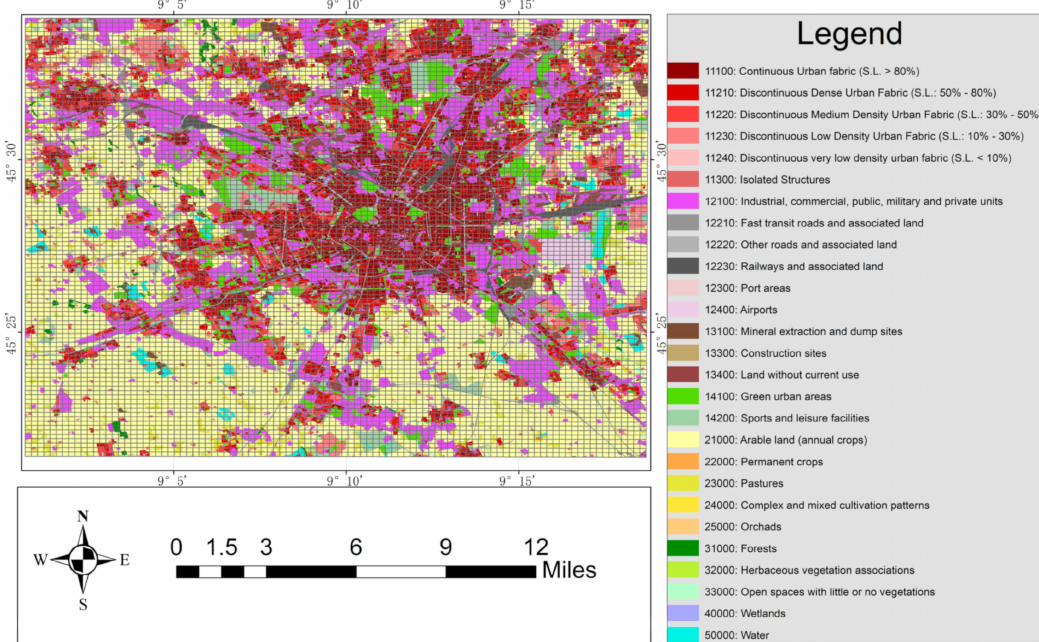
Figure 3. The overlay map of the land-use dataset with 10,000